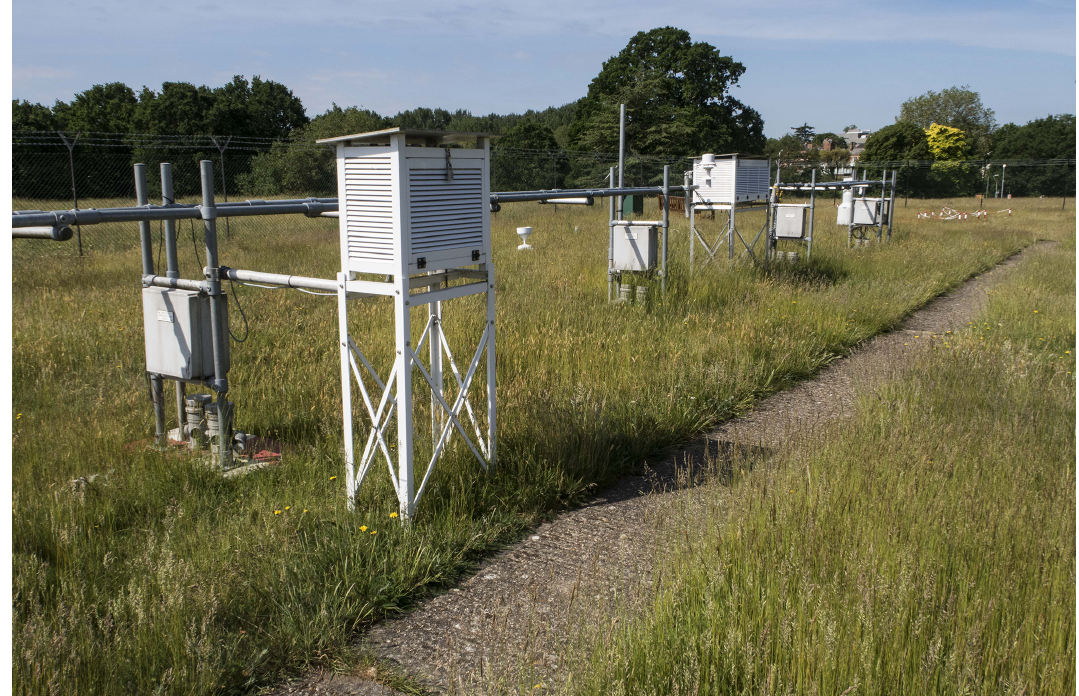
Figure 1. The Reading University Atmospheric Observatory enclosure. The screen nearest to the camera housed the Gill WindSonic anemometer used in this experiment, and its screen door (shown with padlock) opens to true north. This photograph was taken on 27 May 2020. Owing to the coronavirus emergency legislation, the university campus had been closed for 2 months at this time and normal grass cutting and maintenance work had been suspended. Photograph © Stephen